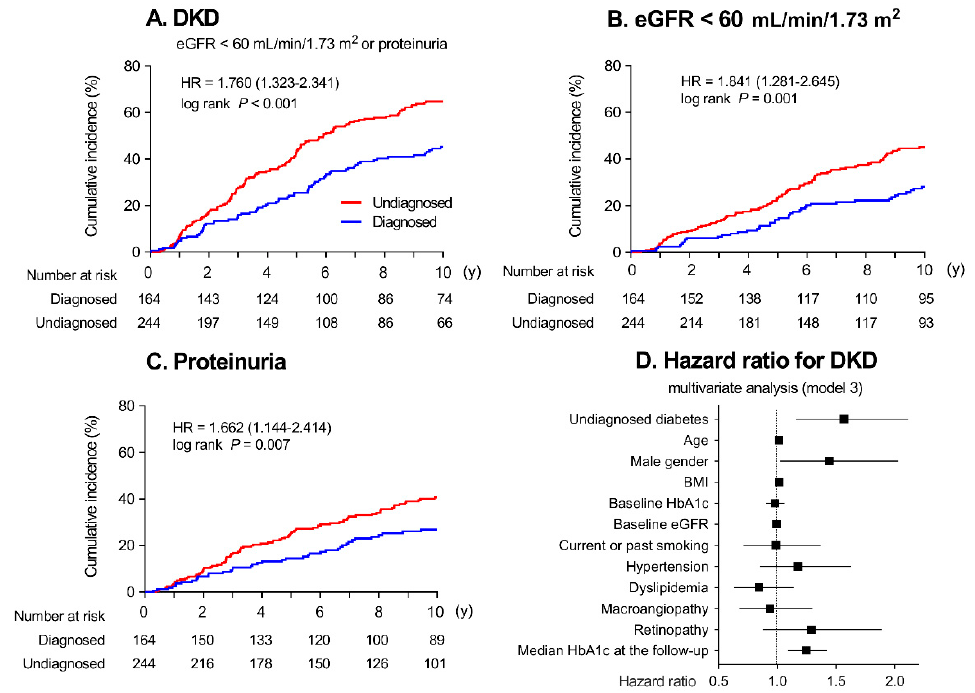
Figure 1. Kaplan–Meier curves for the development of ( A ) diabetic kidney disease (DKD: eGFR < 60 mL / min / 1.73 m 2 or proteinuria), ( B ) eGFR < 60 mL / min / 1.73 m 2 , and ( C ) proteinuria in patients with diagnosed (blue lines) or undiagnosed (red lines) diabetes mellitus. ( D ) Hazard ratios for developing DKD in undiagnosed diabetes (UD) patients (Cox proportional hazards model 3)